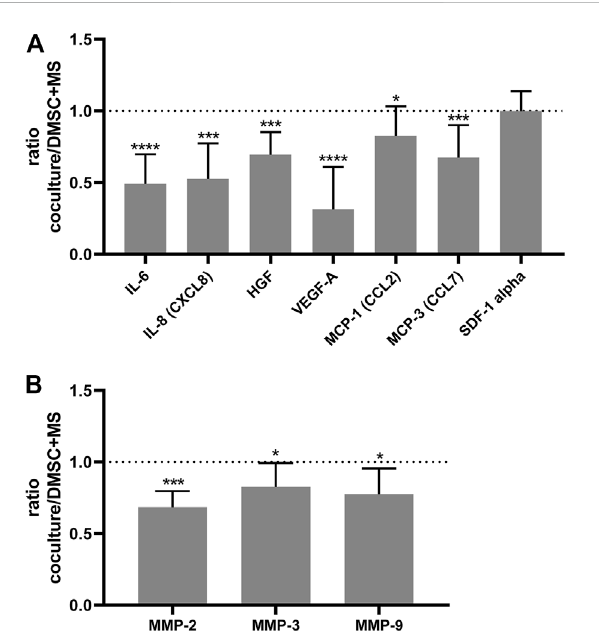
FIGURE 6 DMSC exert a paracrine action that modulates the secretion of soluble factors by SUI myo fi broblasts. (A) Ratio of the amount measured byLuminexofIL-6,IL-8,HGF,MCP-1,MCP-3,andVEGFinthecoculture of DMSC and suburethral myo fi broblast cells relative to the amounts in the monocultures ( n = 6). (B) Ratio of the amount measured by Luminex of MMP-2, MMP-3, and MMP-9 in the co-culture of DMSC and suburethral myo fi broblast cells relative to the amounts in the monocultures ( n = 5). The cells analyzed correspond to passages 5 – 6. These factors are involved in in fl ammation, angiogenesis, ECM- remodeling, and